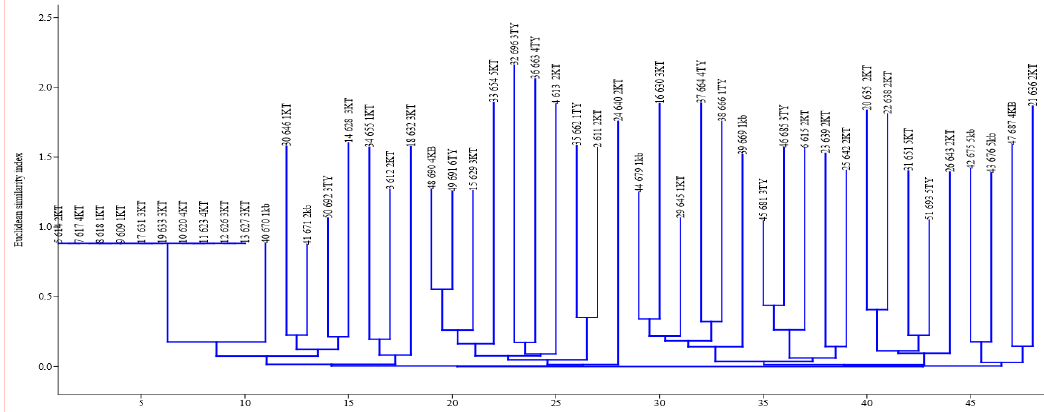
Figure 4. Neighbor-joining dendrogram clusters of ERIC-fingerprints of P. shigelloides strains. Isolates were encoded, for example, 32 696 3TY representing strain number (32), assigned number for PCR confirmed (696), and origin of the isolate (3TY).